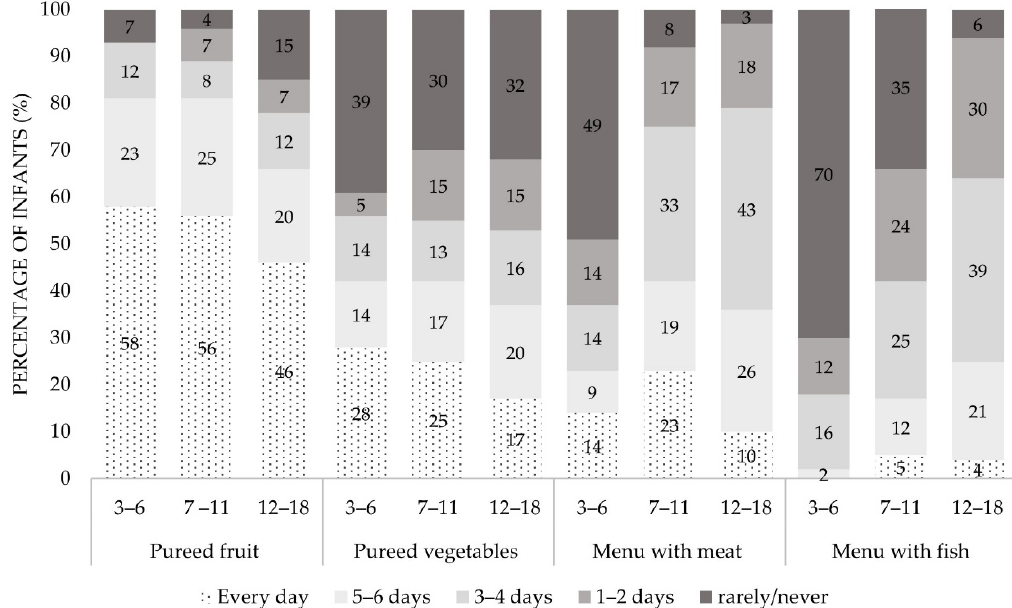
Figure 2. Frequency of intake of home-prepared purées and menus per week. Total n = 586, 3–6 months: n = 43, 7–11 months: n = 216, 12–18 months: n = 327. To specify rarely/never means a consumption with a lower frequency than 1 time per week or even no consumption at all. Percentages are rounded.